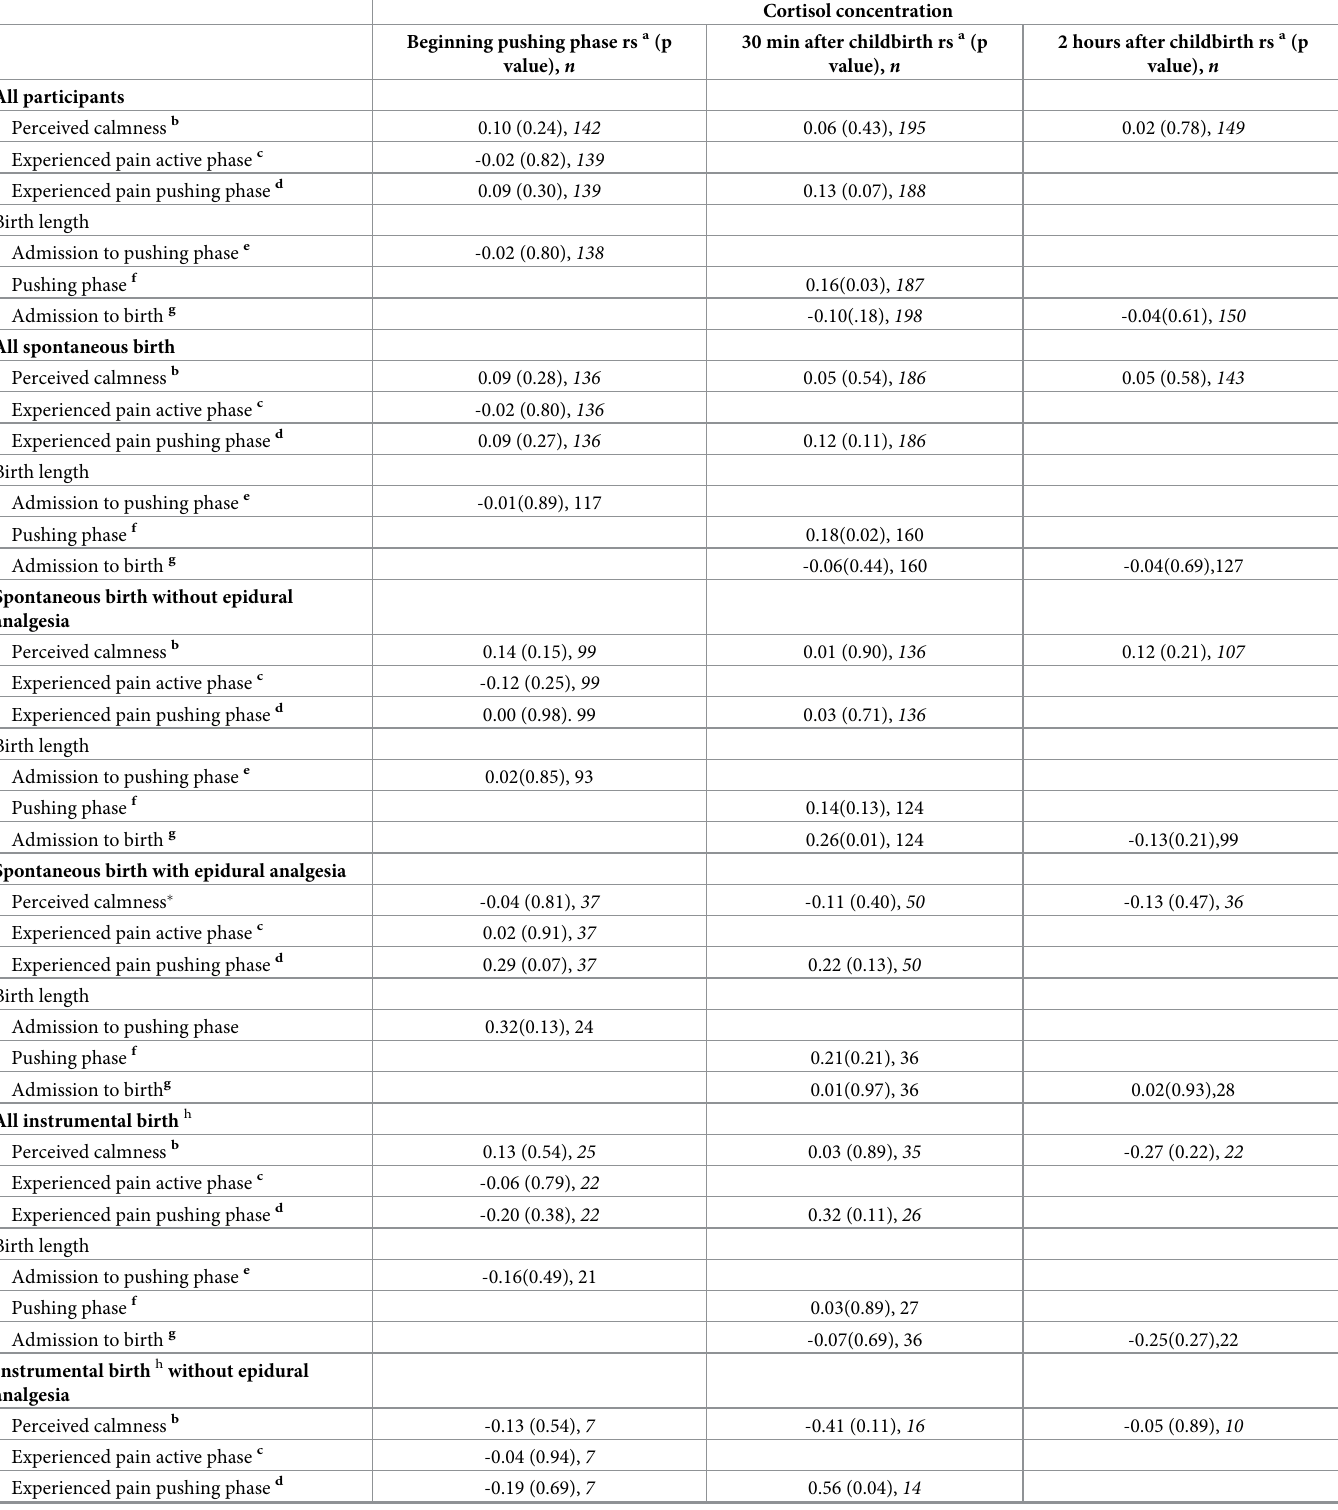
Table 4. Correlation between cortisol concentration and length of birth, experienced pain and calmness during